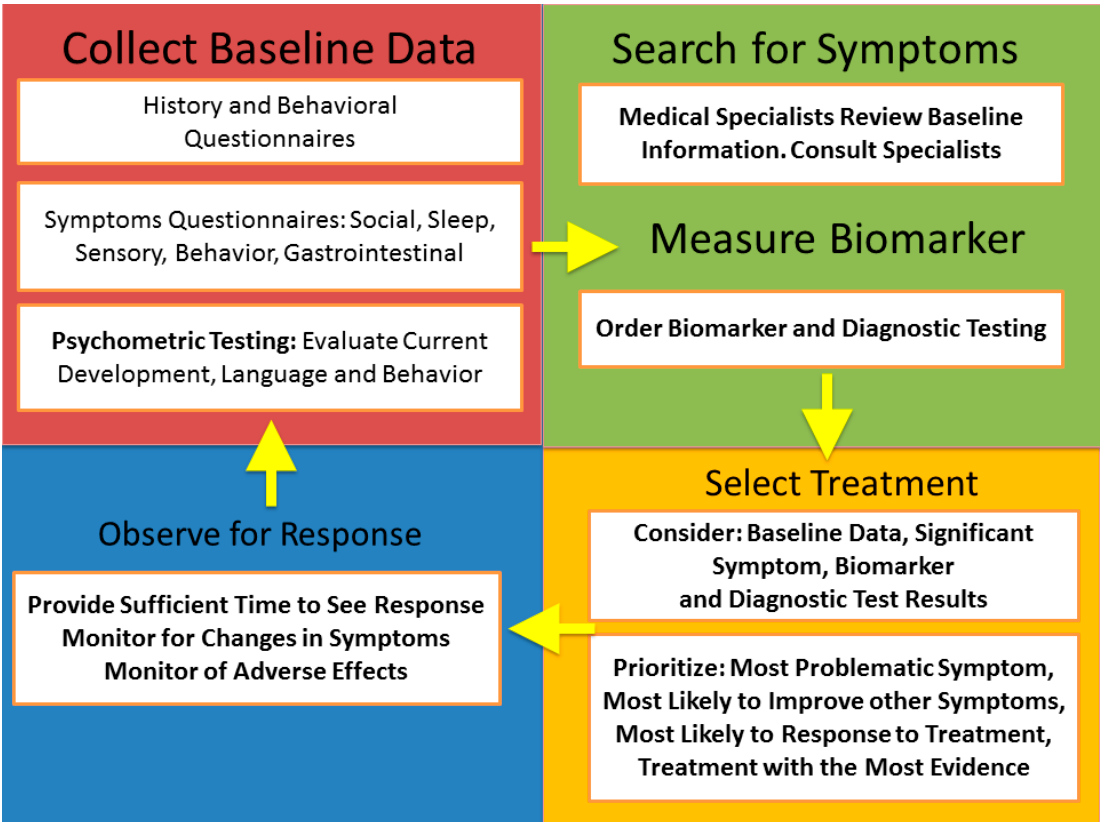
Figure 2. BaS-BiSTOR (collect Baseline data, search for Symptoms, measure Biomarkers, Select Treatment, Observe for Response) flowchart.